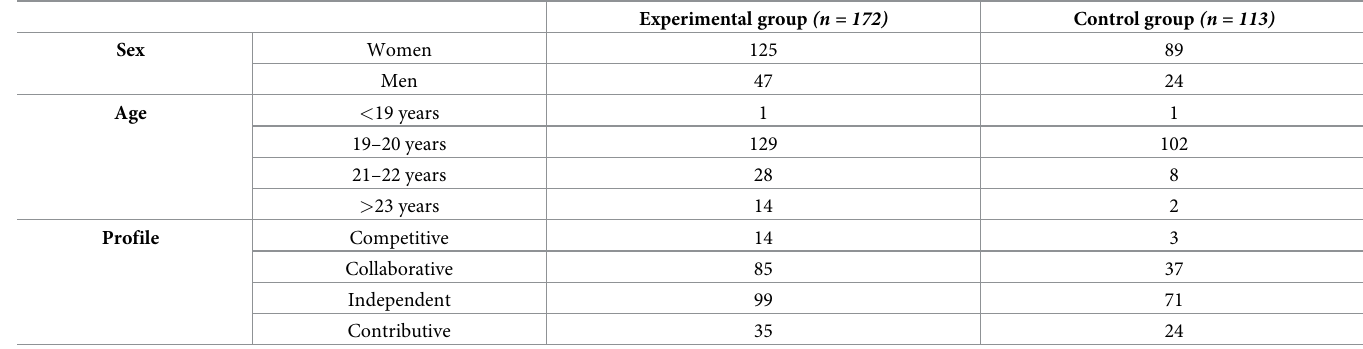
Table 1. Students’ data.